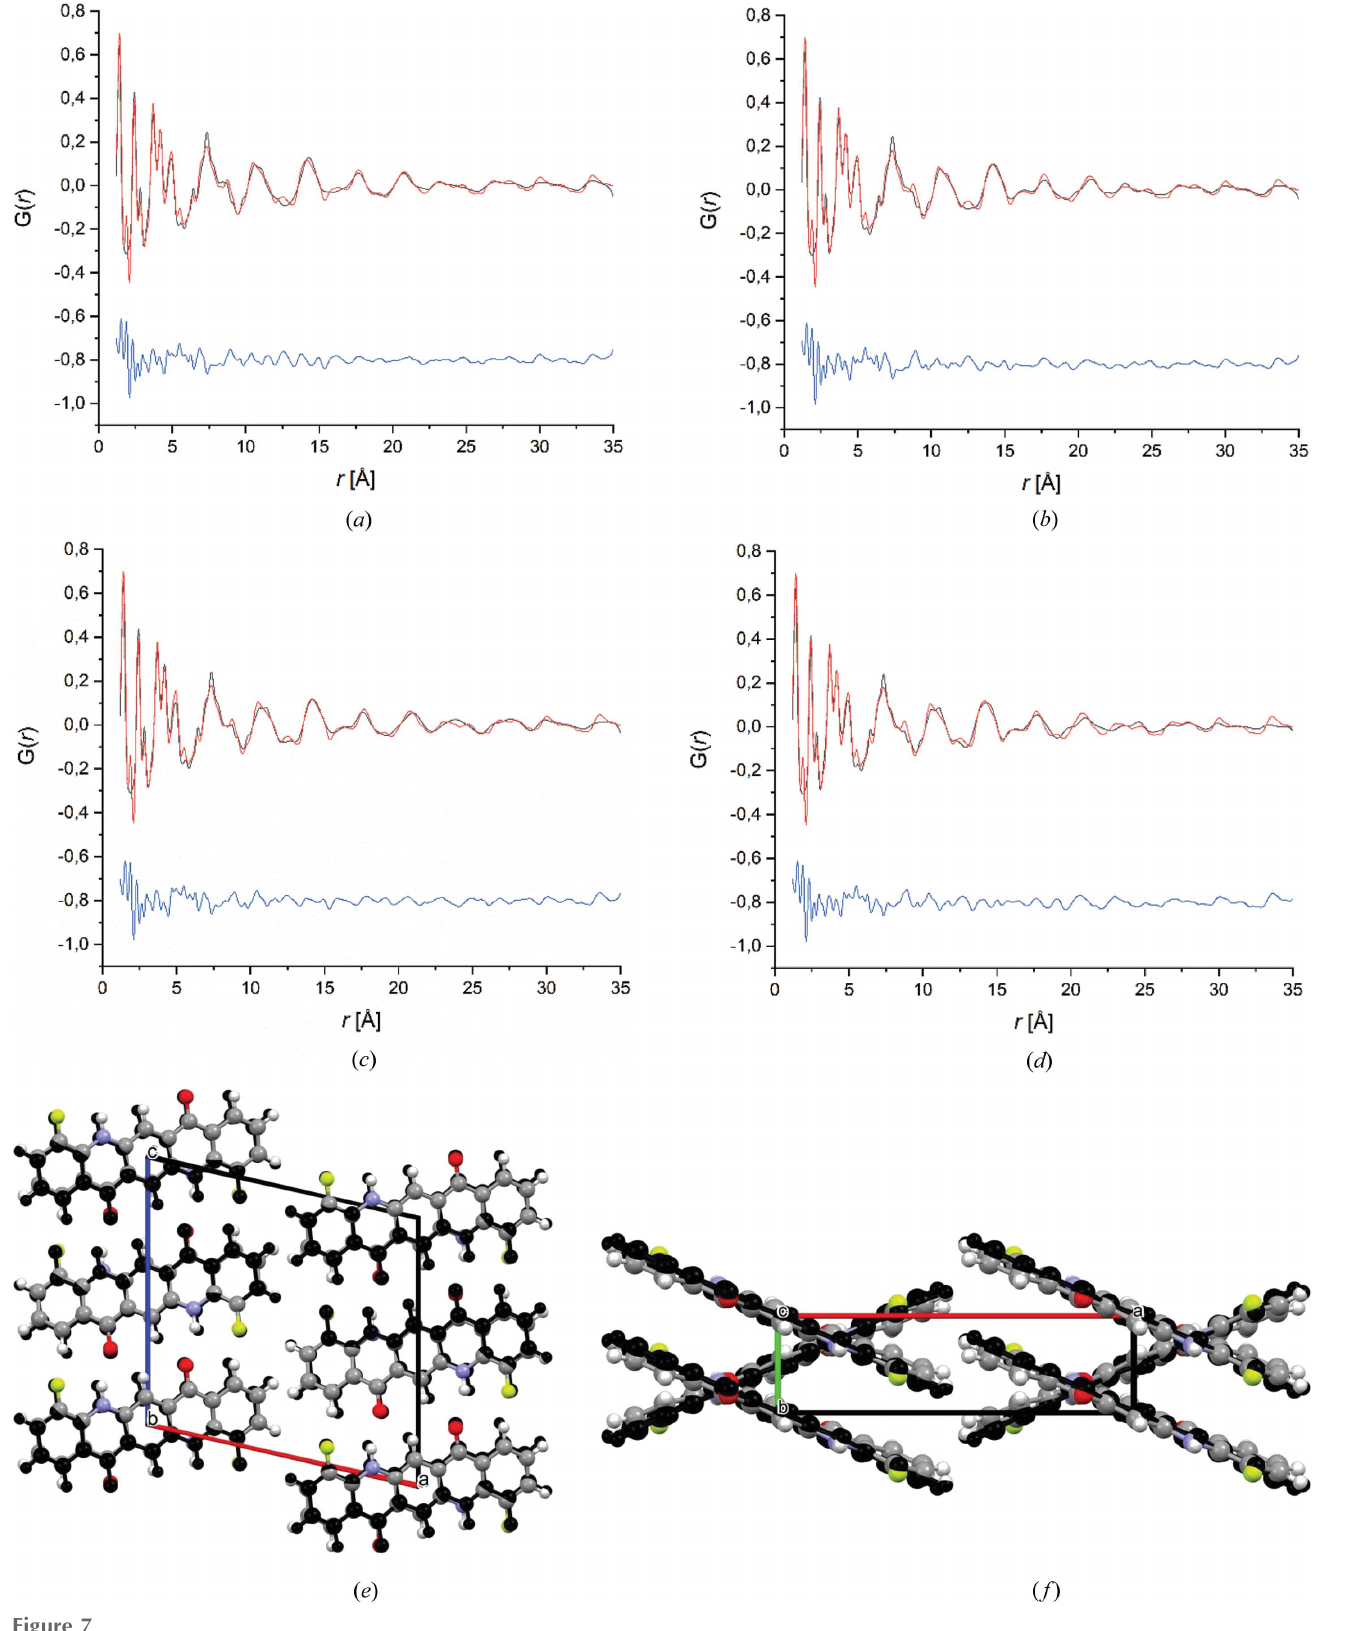
Figure 7 Crystal structure refinement of models A–D by a fit to the PDF using the rigid-body approach with the room-temperature data: ( a ) A, ( b ) B, ( c ) C and ( d ) D. Observed PDF is shown by the red line, calculated PDF is shown by the black line and the difference curve below is blue. ( e ) and ( f ) Comparison of model B obtained by Rietveld refinement (black) and by fit to the PDF (coloured). View directions: ( e ) [010], ( f ) Carina Schlesinger et al. (cid:2) Four structural models of DFQ with similar PXRD patterns IUCrJ (2022). 9 , 406–424